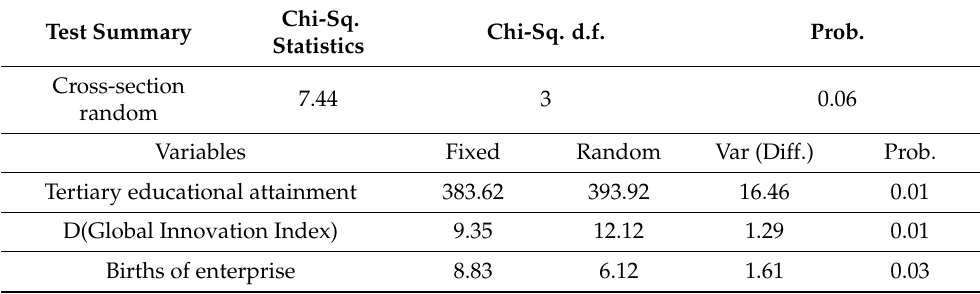
Table 5. Correlated random effects—Hausman test and cross-section random effects test comparisons.